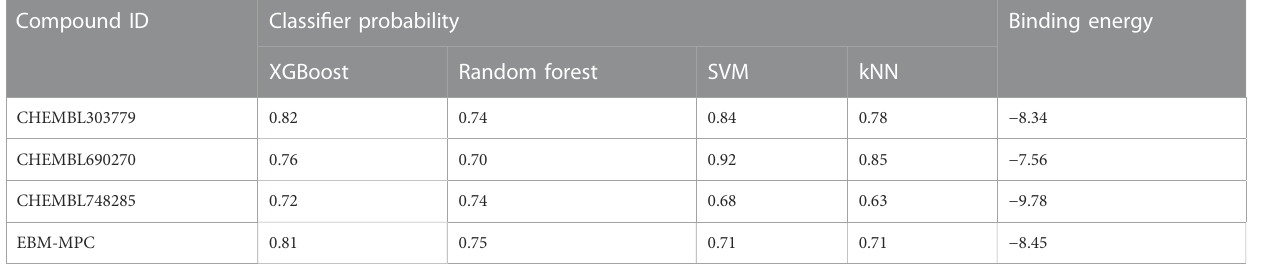
TABLE 2 Probability scores and docking scores of the selected compounds. Compound